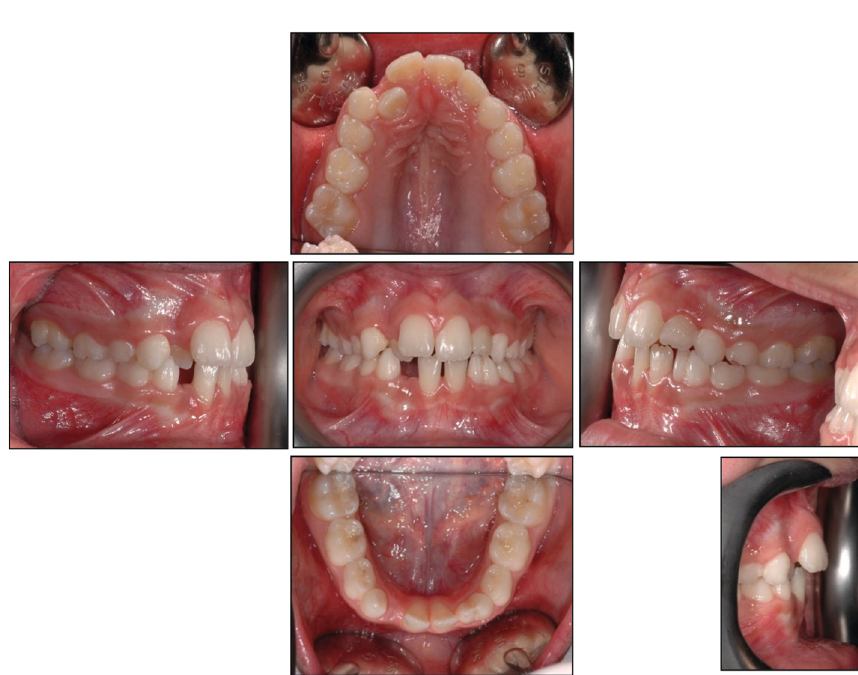
Figure 2: Initial intraoral photographs.